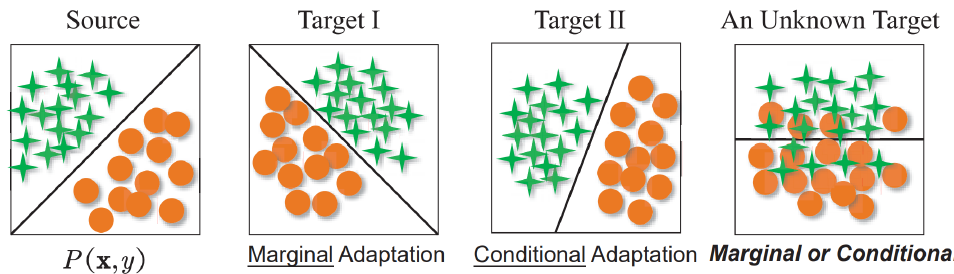
Figure 1. Different effects of marginal and conditional distributions in transfer learning applica- tions [24].